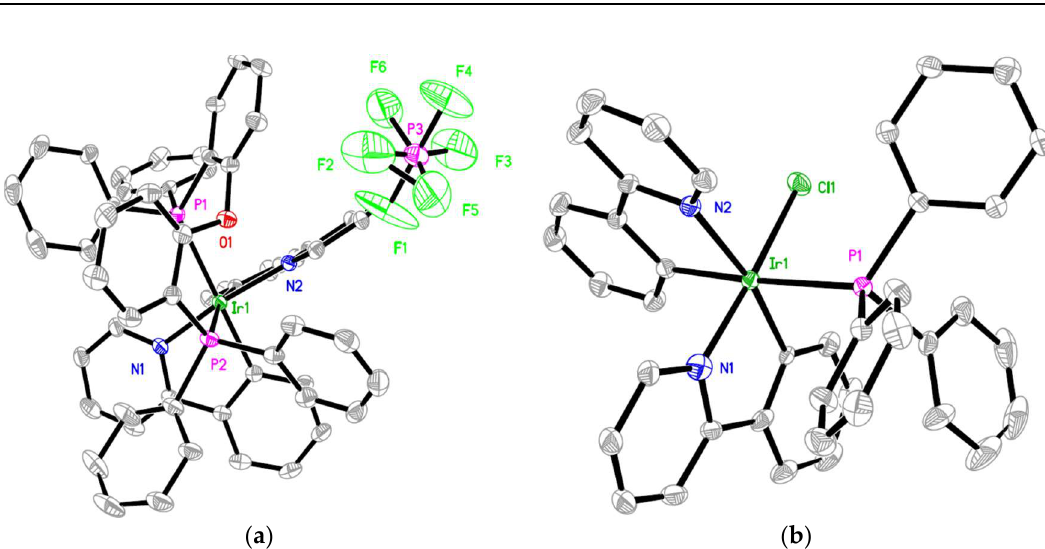
Figure 1. Single crystal structure of Ir(ppy) 2 (BPE) ( a ) and Ir(ppy) 2 (TPP) ( b ). Although the Cl atom is small enough to avoid the effect from the TPP steric hin- drance, the Ir-Cl bond in Ir(ppy) 2 (TPP) was still longer than the literature values [10,11]. In addition, the Ir-P bond length values in Ir(ppy) 2 (BPE) and Ir(ppy) 2 (TPP) (~2.5 Å) were longer than those in other metal complexes with ligands of BPE and TPP (<2.3 Å) [10,11]. This fact indicates that the large steric hindrance of the BPE and TPP ligands weakens their own coordination affinity as well. As we mentioned above, such a large steric hin- drance may improve the emissive performance of Ir(ppy) 2 (BPE) and Ir(ppy) 2 (TPP) in the solid state by reducing the ACQ effect, which will be discussed below. These bond length and bond angle values of Ir(ppy) 2 (BPE) and Ir(ppy) 2 (TPP) were generally rather similar to